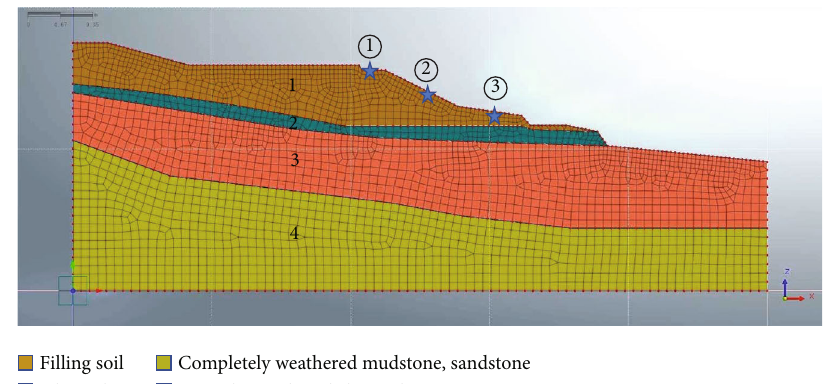
Figure 14: The model of Wangyan highway landslide and grid section